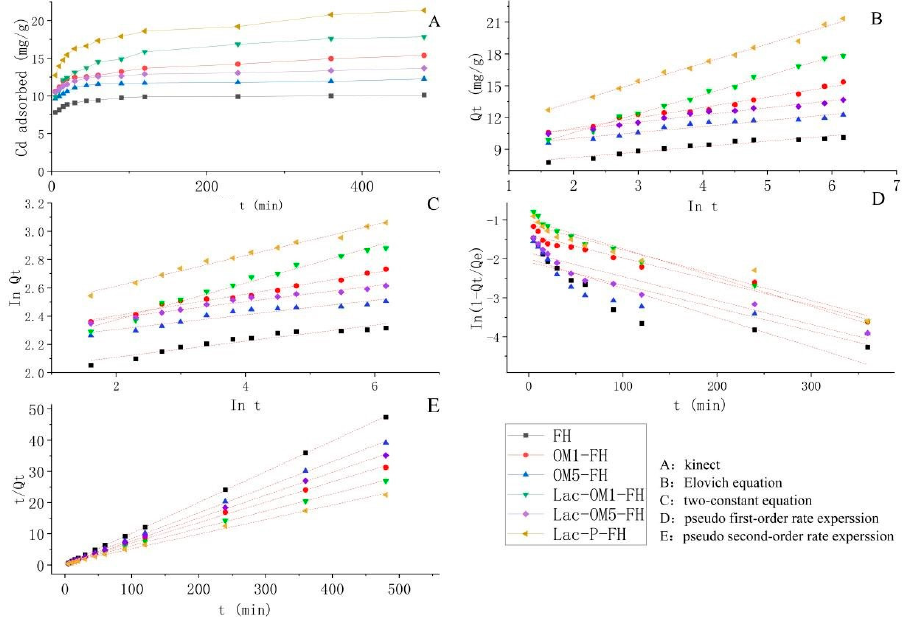
Figure 5. Adsorption kinetics plots of cadmium on ferrihydrite and iron–organic matter associa- tions.